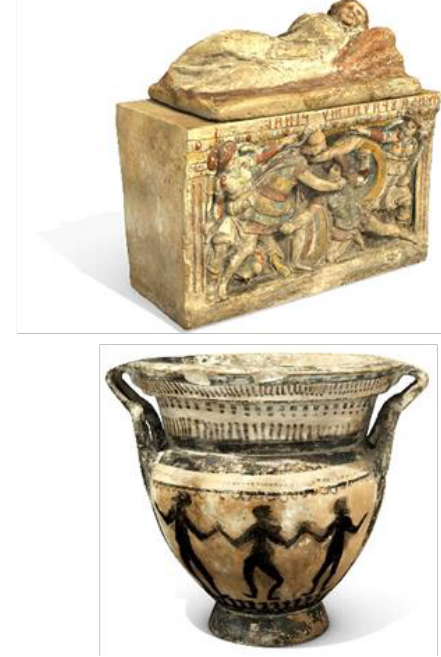
Figure 2: Cases study. Dense sampling polygonal mesh (by Spider scanner) with high-quality resolution texture mapping (by Nikon